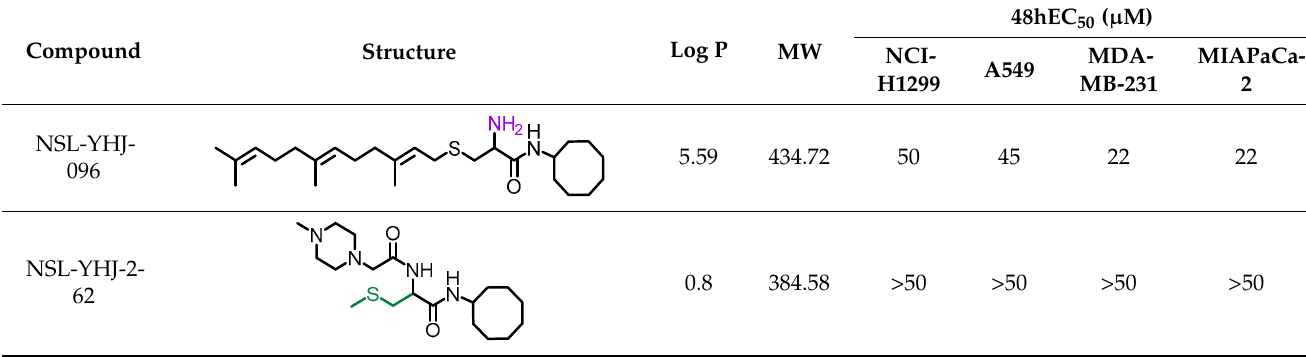
Table 1. Structure activity relationships of the PCAIs. The physicochemical properties and inhibition of cancer cell viabilities by the PCAIs. The EC 50 values were obtained from concentration-response curves following 48 h treatment with the indicated PCAIs. Various structures have been color-coded for easier comparisons.